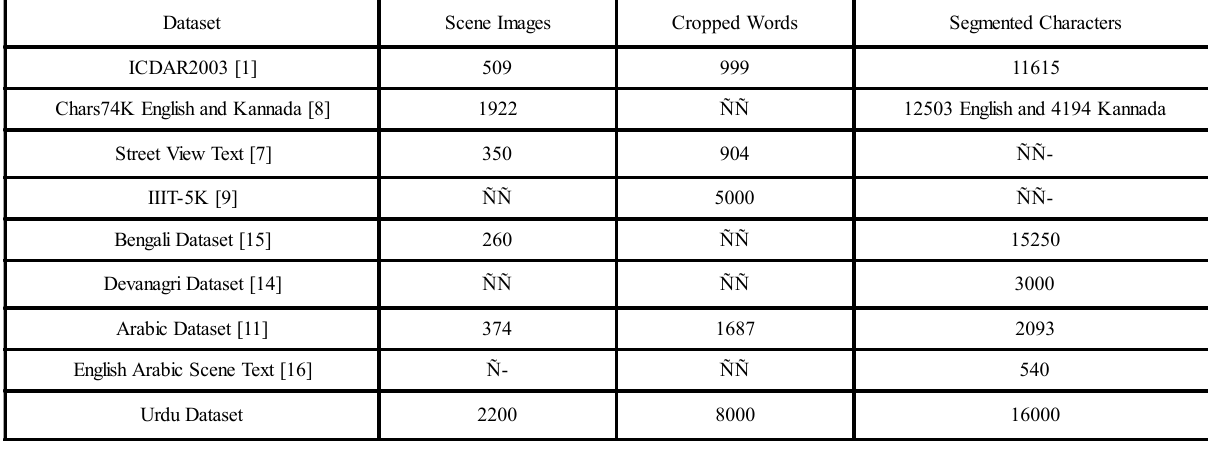
TABLE 1. SUMMARY AND COMPARISON OF DIFFERENT NATURAL SCENE TEXT